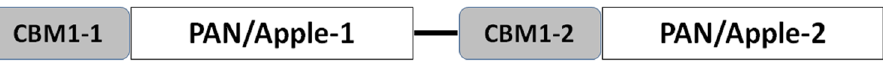
Fig 1. Schematic representation of CBEL protein domains. CBM1s and PAN/Apple are numbered from the N- to the C-terminus of the protein. CBM1s and PAN/Apple domains are symbolized by grey and white boxes respectively. The linker is represented by a black